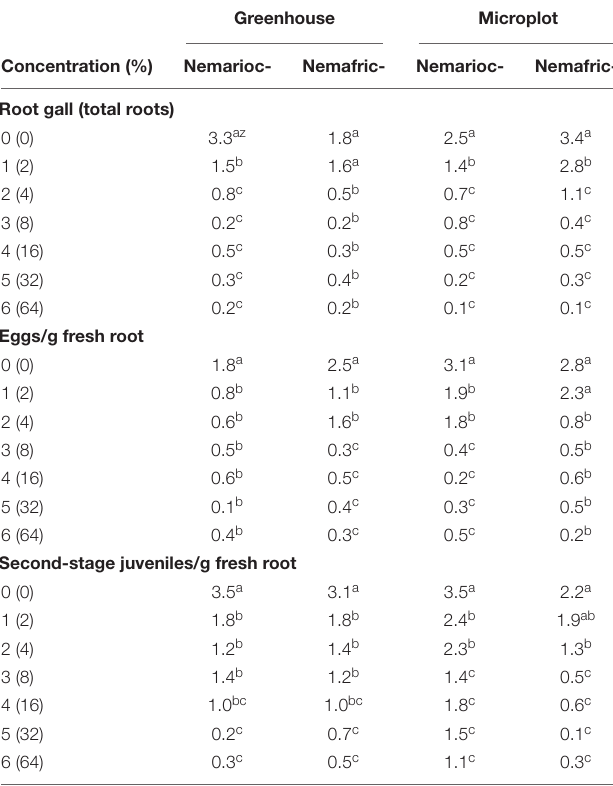
TABLE 1 | Effects of priming pea seeds in Nemarioc-AL and Nemafric-BL phytonematicides on pea plants subjected to M. incognita .